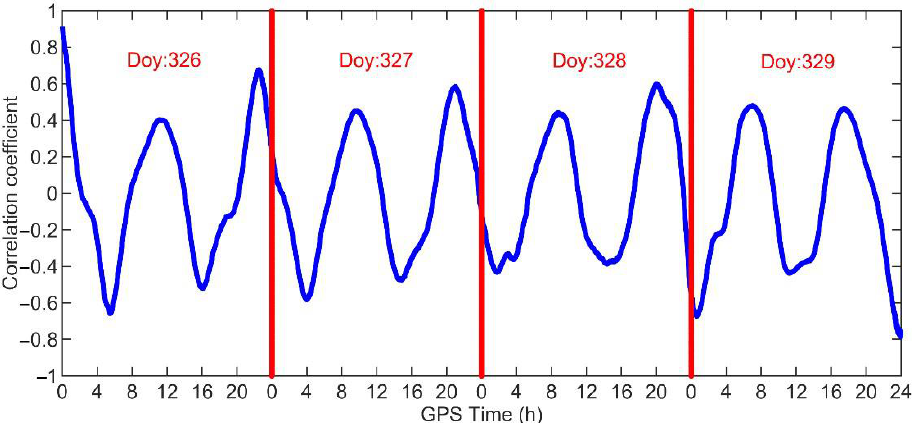
Figure 11. The Pearson correlation coefficient of the code pseudorange variations of R21 from DOY 326 to DOY 329, 2020. The blue line denotes the Pearson correlation coefficient, and the red vertical line is the dividing line between two consecutive days.